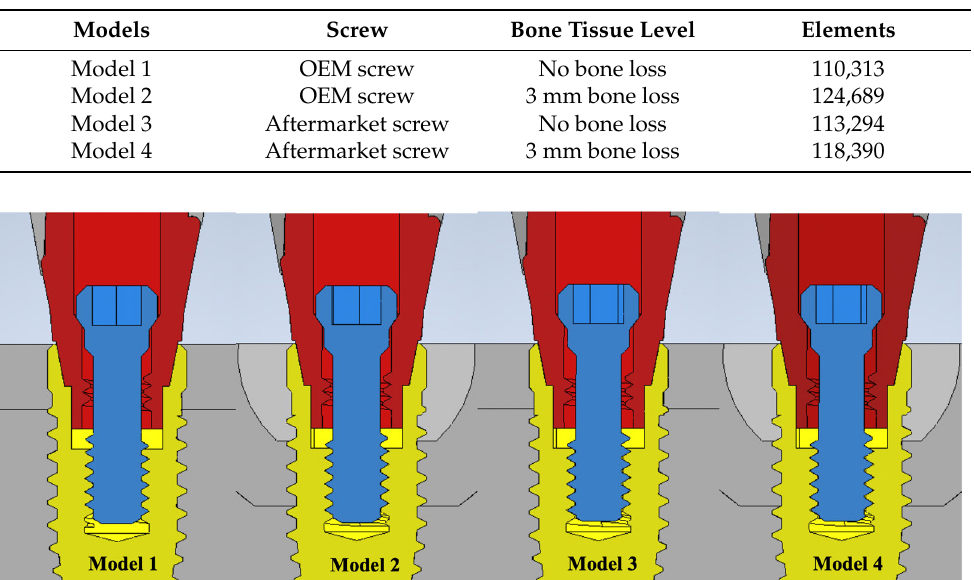
Table 1. Model descriptions and element numbers of the four finite element models.